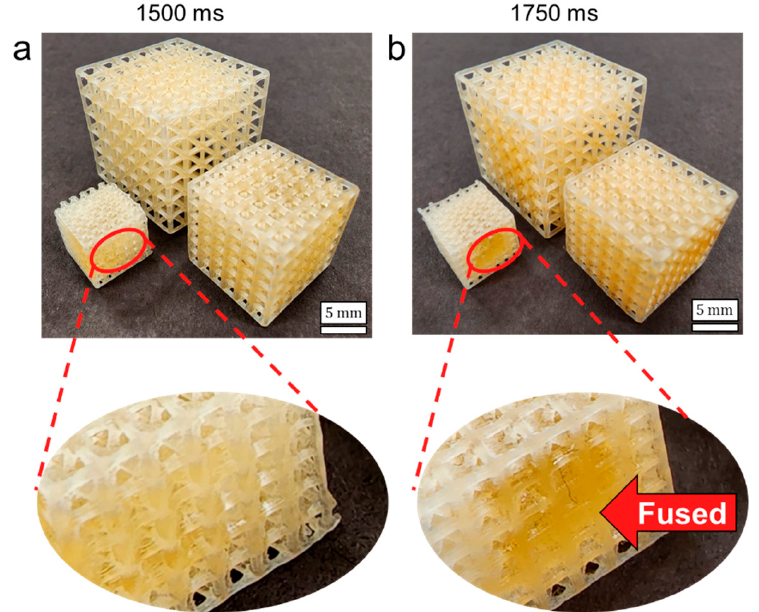
Figure 13. Fabricated BCC-0.5 ρ r , BCC-0.4 ρ r , and BCC-0.3 ρ r lattices processed with exposure times per layer of ( a ) 1500 ms and ( b ) 1750 ms. Circled areas highlight the higher proportion of fused pores for the 1750 ms condition.